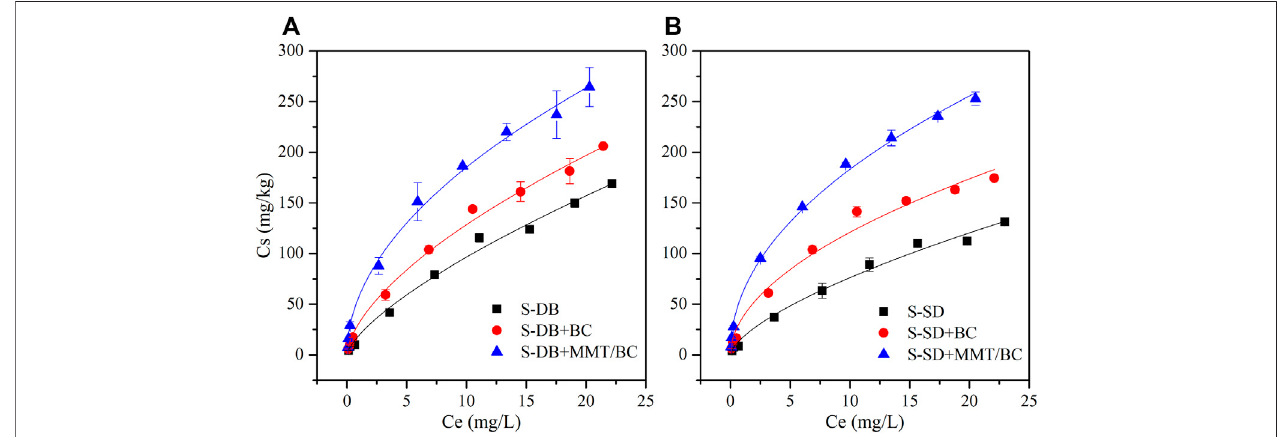
FIGURE 6 | Sorption isotherms of atrazine onto soil, BC-soil mixtures, and MMT/BC-soil mixtures [ (A) : S-DB; (B) : S-SD). Isotherm data were fi tted to Freundlich model.